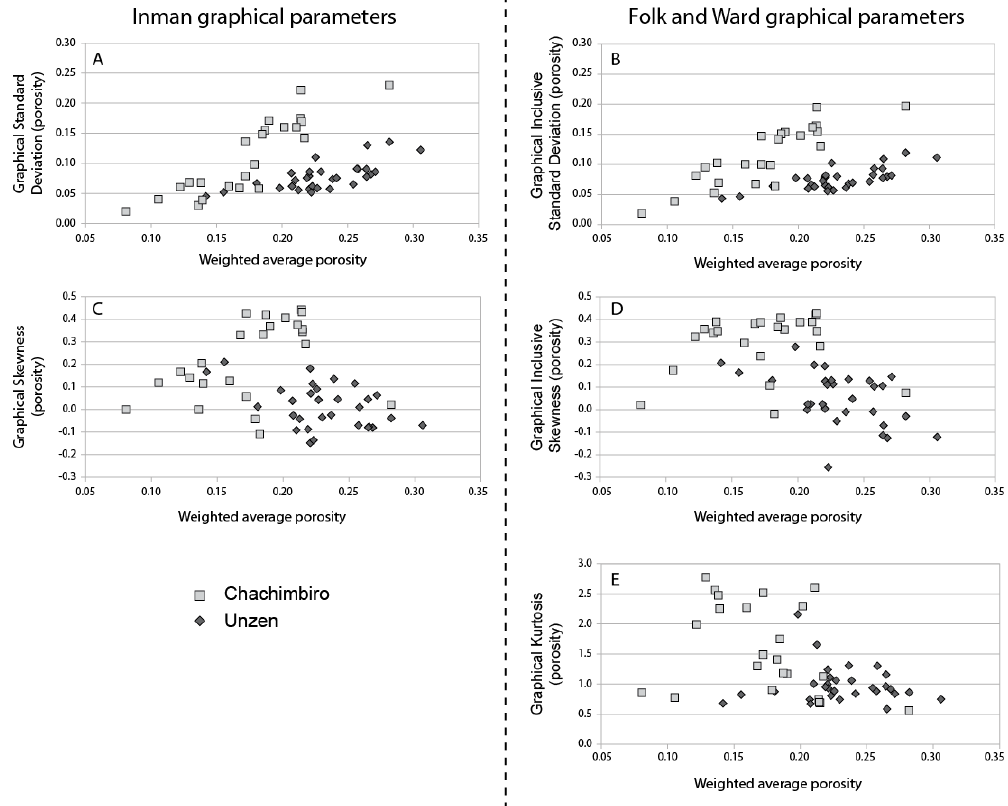
Figure 5. Graphical parameters for the Chachimbiro and Unzen data sets. Only high stability (slope<0.5%) sample sets are used in this figure. Note that the two data sets show lower superposition with the Folk and Ward parameters than with the Inman parameters, in particular when using the Skewness (d)